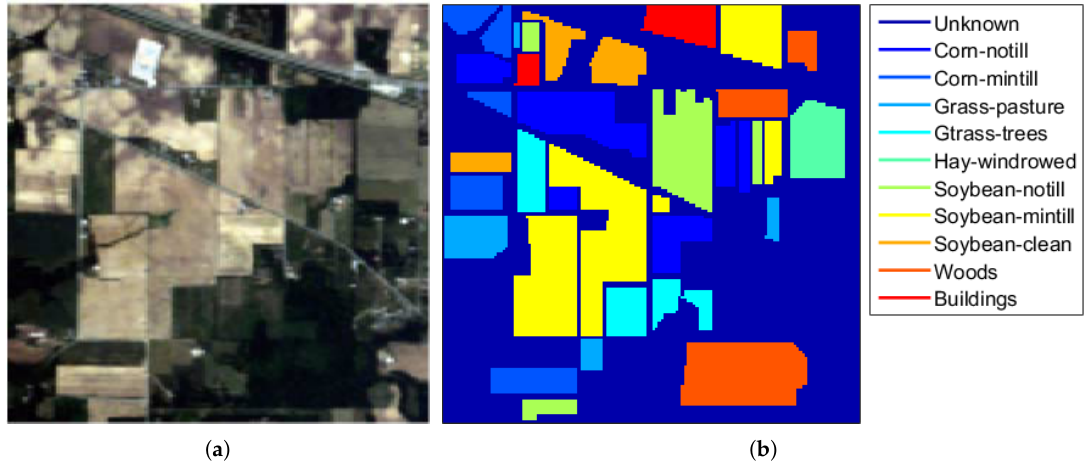
Figure 4. Indian Pines: ( a ) RGB image; ( b ) ground reference map.